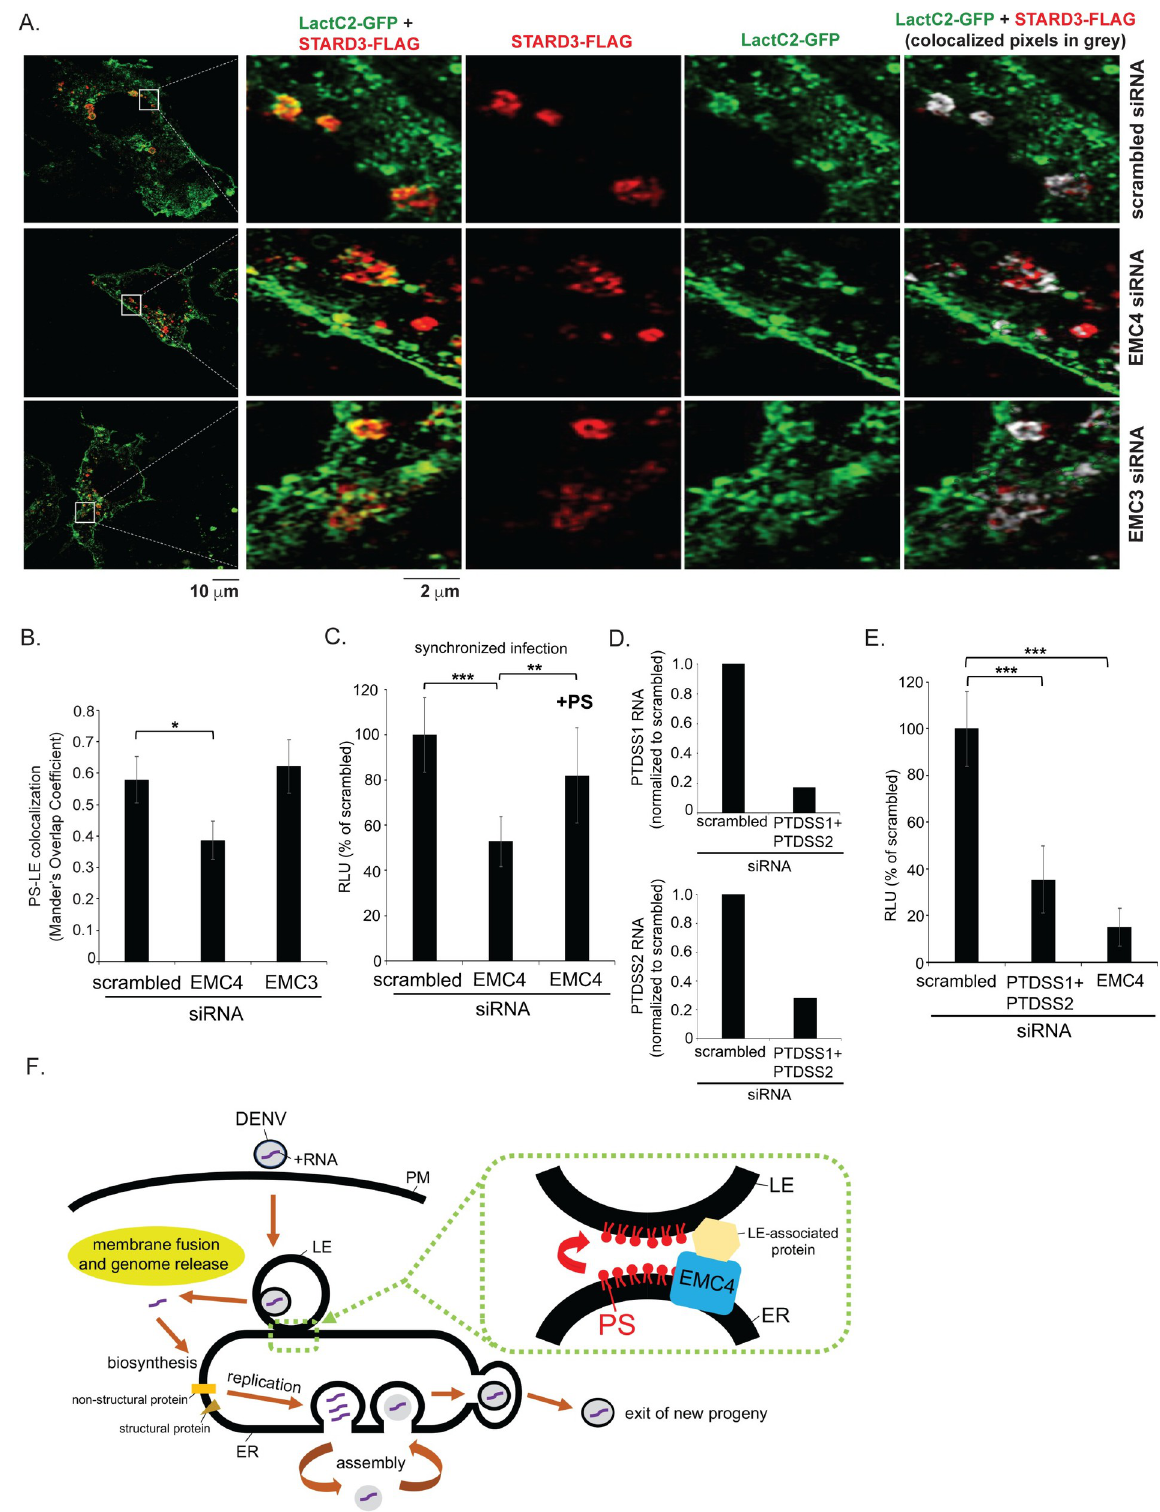
Fig 5. EMC4 plays a role in efflux of phosphatidylserine to the endosome. A. Huh 7.5.1 cells transiently expressing LactC2-GFP and STARD3-FLAG were transfected with the indicated siRNAs, fixed, stained with indicated antibodies and imaged by structured